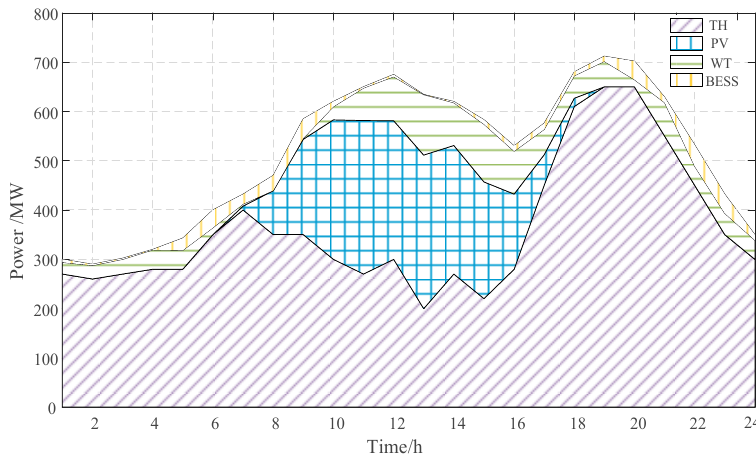
Figure 8. The optimal scheduling plan in case 5.